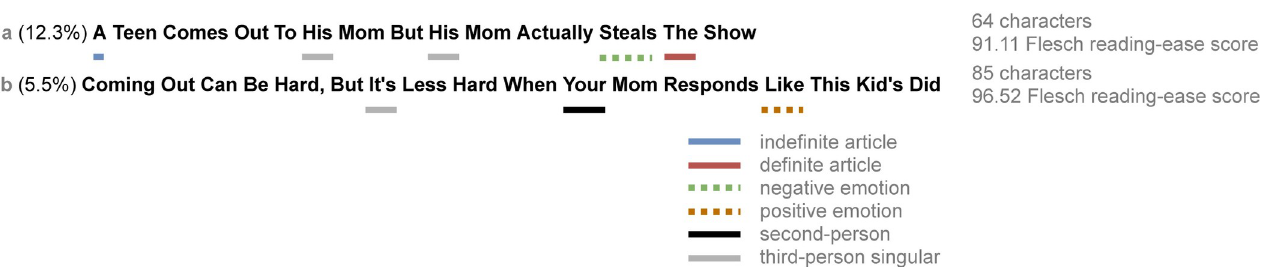
Fig 1. Example of a headline variation experiment pair and derived features. The a variant (top) had a higher clickthrough rate (12.3%) than the b variant (bottom; 5.5%). The a variant contains a definite and an indefinite article, a negative emotion word, and a third-person singular pronoun, whereas the b variant contains a positive emotion word, a third-person singular pronoun, and a second-person pronoun. Character count and Flesch reading-ease score are also shown.